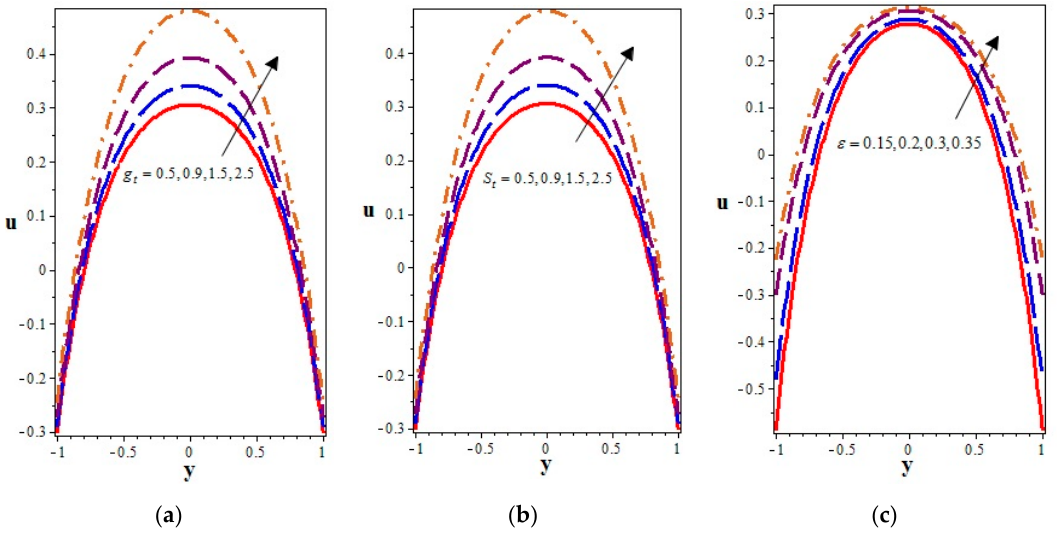
ε = 0.3, ( b ) S ε = 0.3, and Figure 3. Axial velocity profiles for: ( a ) Figure 3. Axial velocity profiles for: ( a ) g t when S t = 0.5, t when g t = 0.5, ( c ) ε when S t = 0.5, g t = 0.5. Other parameters were fixed as λ 1 = 1.5, H a = 0.3, D a = 0.3, M = 0.1, g c = 0.5, S r = 0.5, S c = 0.1, Q = 0.9, β = 0.4, ε = 0.3, and δ = 0.3 at x = Figure 3. Axial velocity profiles for: ( a )